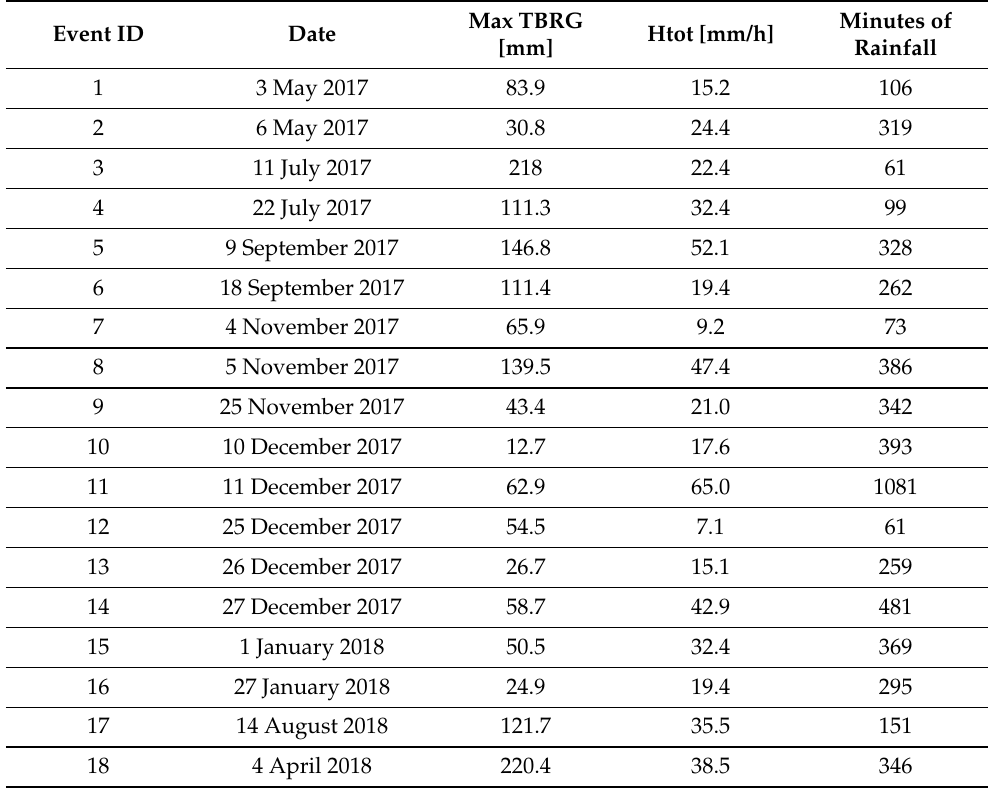
Table 1. Selection of rainfall events and overall quantities as measured by the DICCA